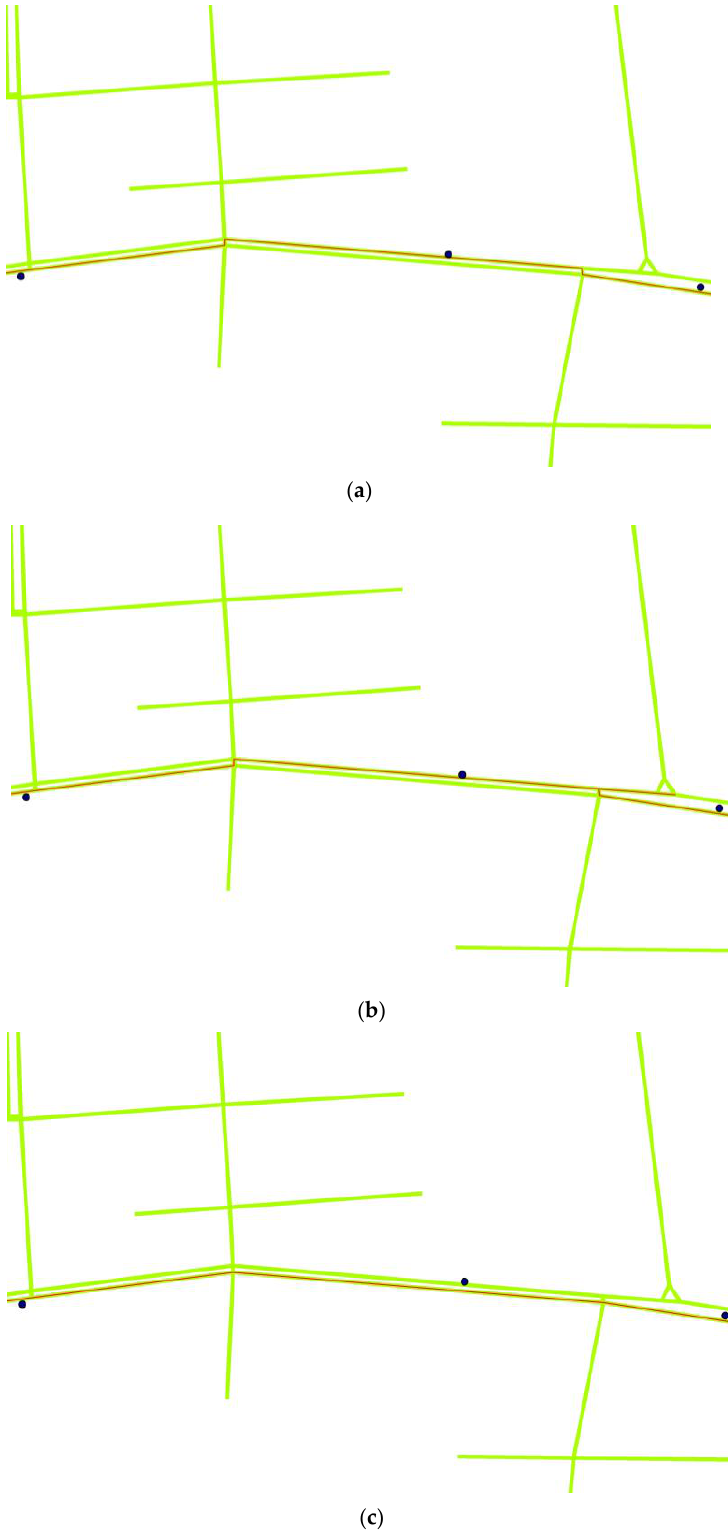
Figure 15. Visual comparison results of the algorithms under parallel road topology. ( a ) ST-Matching algorithm. ( b ) SD-Matching algorithm. ( c ) The proposed